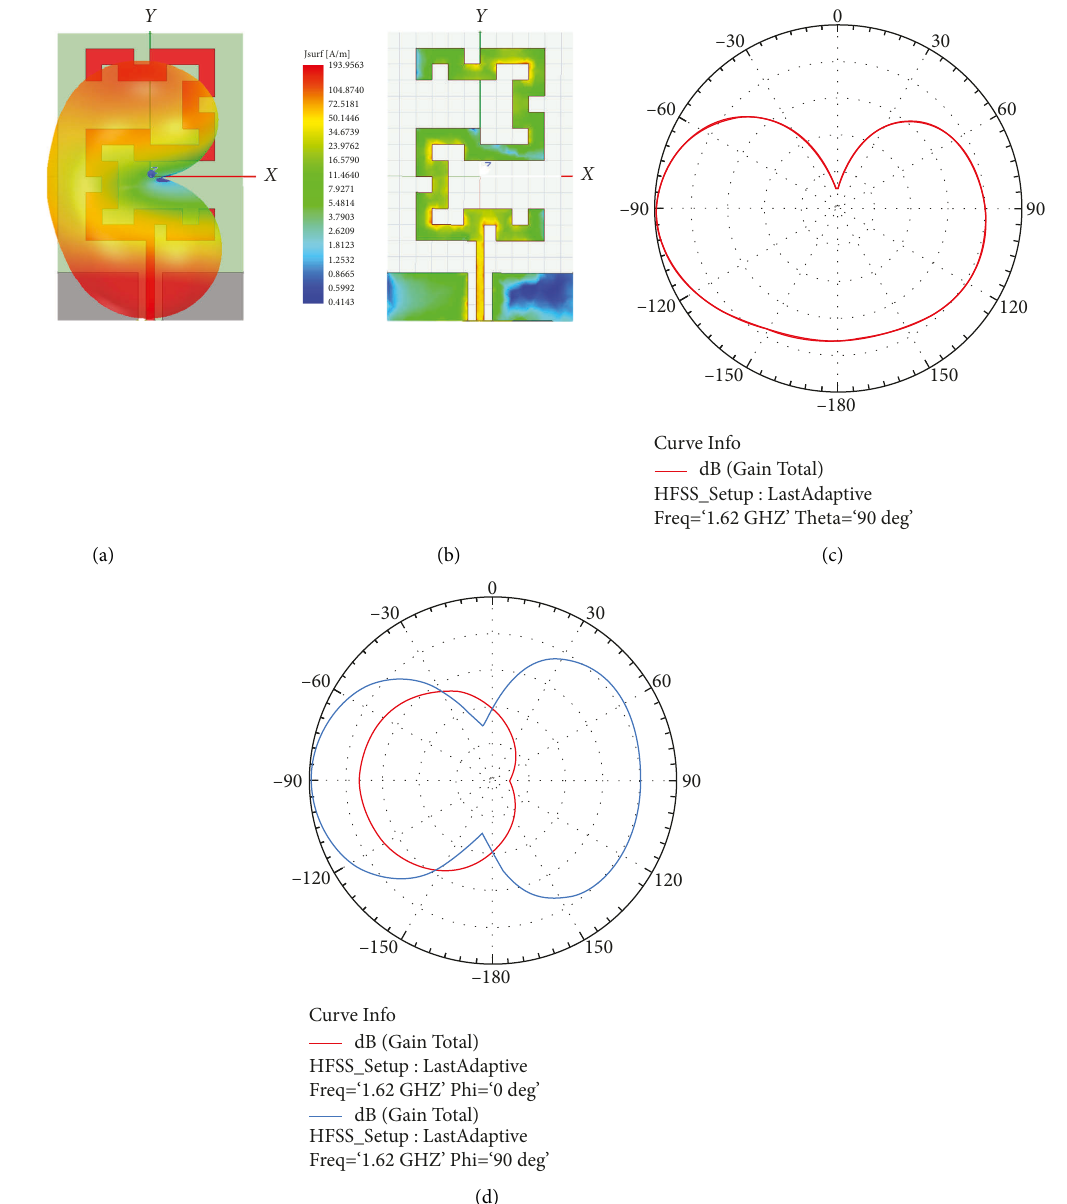
Figure 7: (a) Simulated 3D radiation pattern of the antenna, (b) surface current distribution and 2D radiation pattern, (c) over the azimuth plane ( E -plane), and (d) elevation plane ( H -plane) for the proposed antenna at